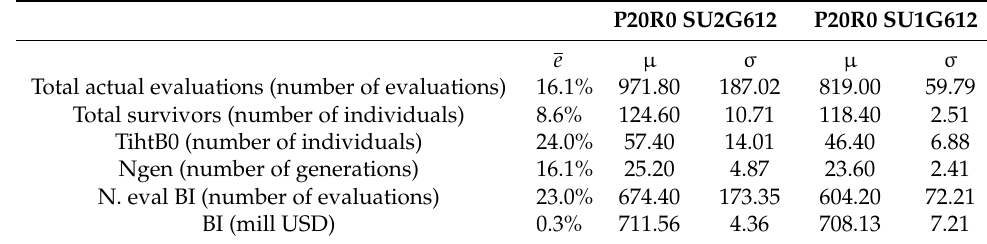
Table 12. Repeatability of the measurement